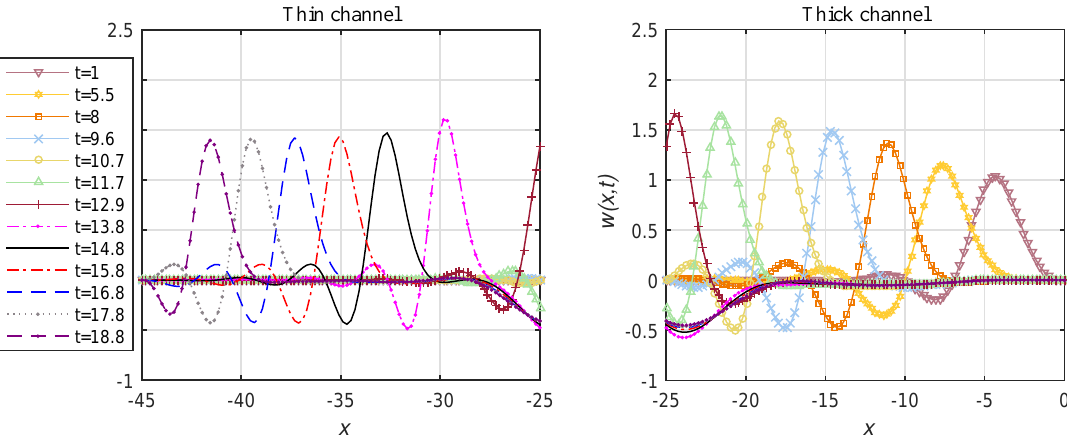
Figure 9. The experiment with α 2 = 4.9 α 1 ( a = 1/8, b = 4.9/8, c = 1); the time ranges from t = 1 to 18.8.